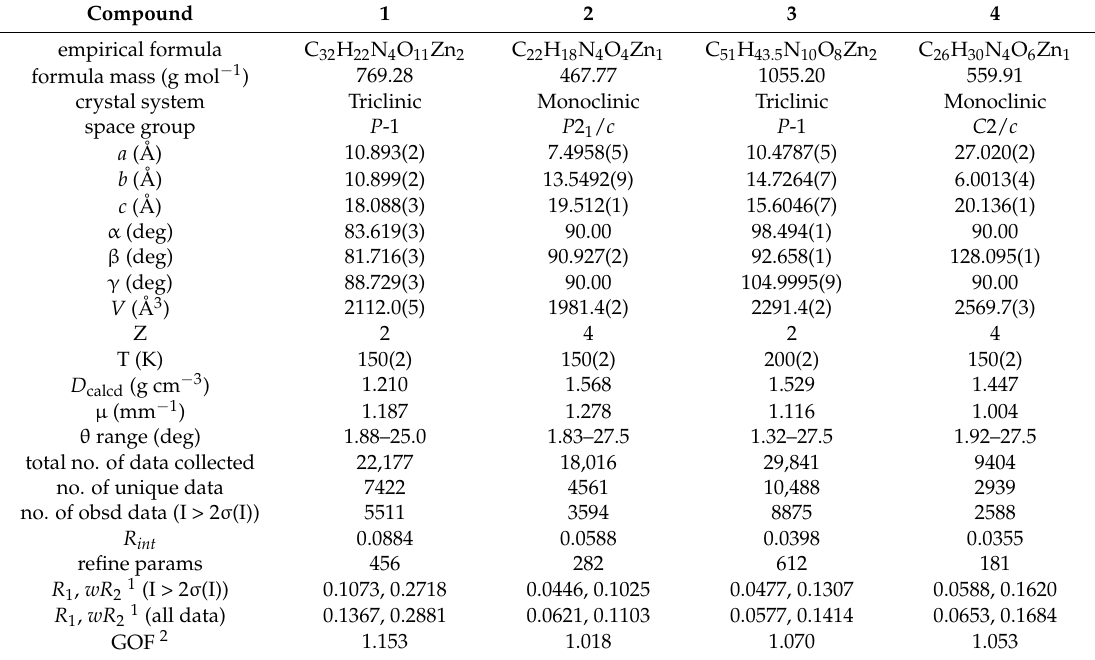
Table 1. Crystal data and refinement details of compounds 1 – 4